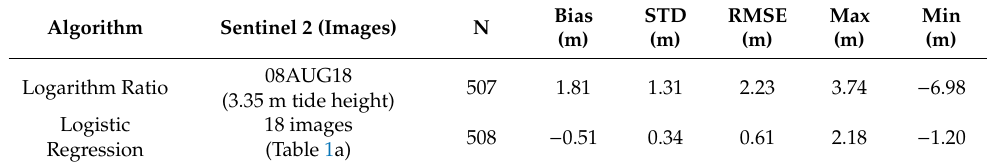
Table 3. Statistical analysis of the di ff erences between the hydrographic survey at Tagus basin (Azinheira) and the satellite-derived bathymetry (Logarithm Ratio and Logistic Regression). N is the number of samples.